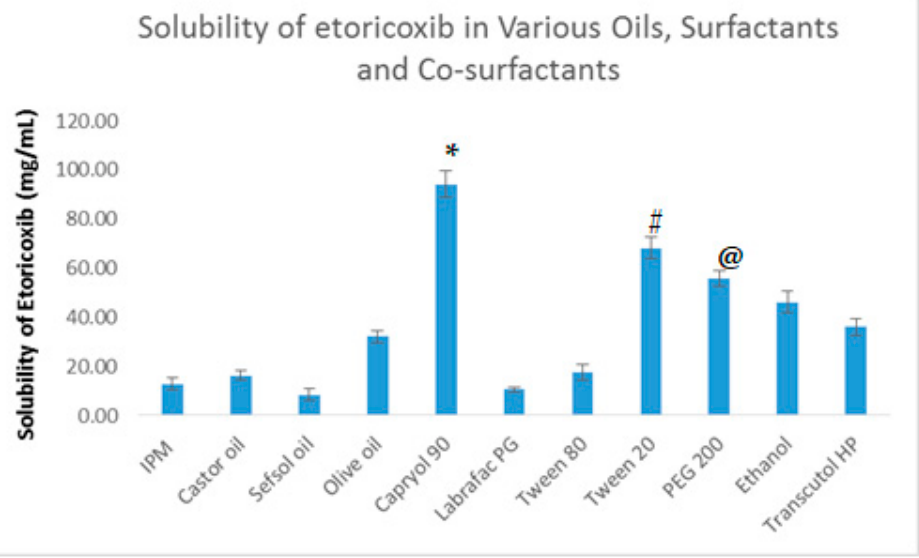
Figure 1. The solubility profile of ETO in different components (oils, surfactants, and co-surfactants) of the NE system. Values are expressed as mean ± SD ( n = 3). * denotes significant difference between capryol 90 ( p < 0.05) vs. other excipients. # denotes significant difference between tween 20 ( p < 0.05) vs. all other excipients. @ denotes significant difference between PEG 200 ( p < 0.05) vs. all other excipients.